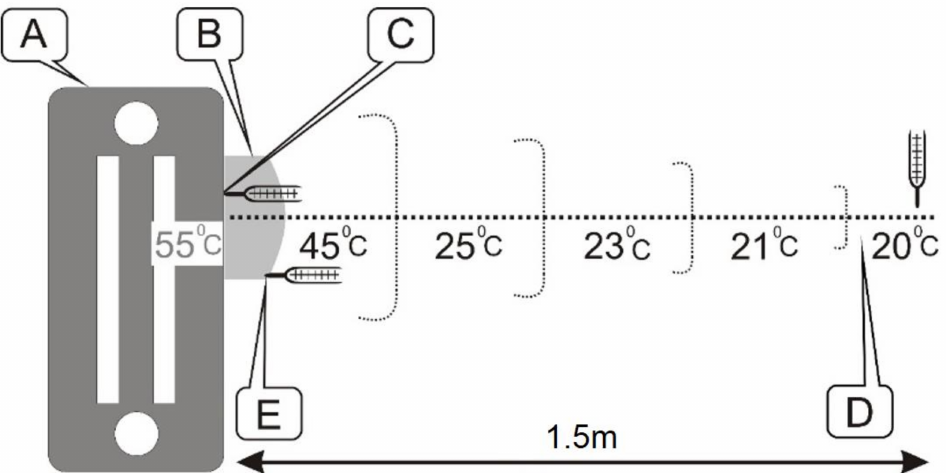
Figure 4. Temperature distribution in the HCA with two temperature sensors: A—radiator, B—HCA, C—temperature of radiator ( t HS ), D—room temperature ( t i , L ), and E—temperature of HCA on the room side ( t RS